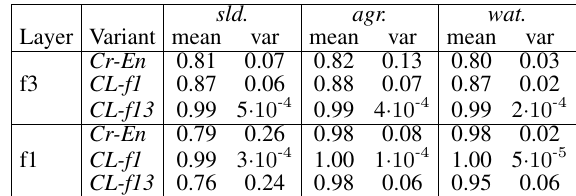
0.99 - 1.00 with a small variance; the other layers are also af- fected, but to a lesser degree. This is another indicator that the cosine loss does lead to well-defined clusters, which can sup- port the classification if it occurs in the last layer of the network (f1). The cosine similarity between the mean feature vectors of the last layer (f1) can be interpreted as an indicator for the similarity of classes. For instance, table 7 shows a high co- sine similarity between the mean feature vectors of grassland and agriculture , two classes that have a similar appearance at least in some parts of the vegetation cycle. Table 7 also shows that the cosine similarity between the mean feature vectors of the classes increases significantly if the cosine similarity loss is used. It would seem that the cosine similarity does not only lead to more compact clusters, but also to smaller differences between the clusters. However, as the variance of the similari- ties becomes even smaller, the separation of the clusters is still possible. sld.